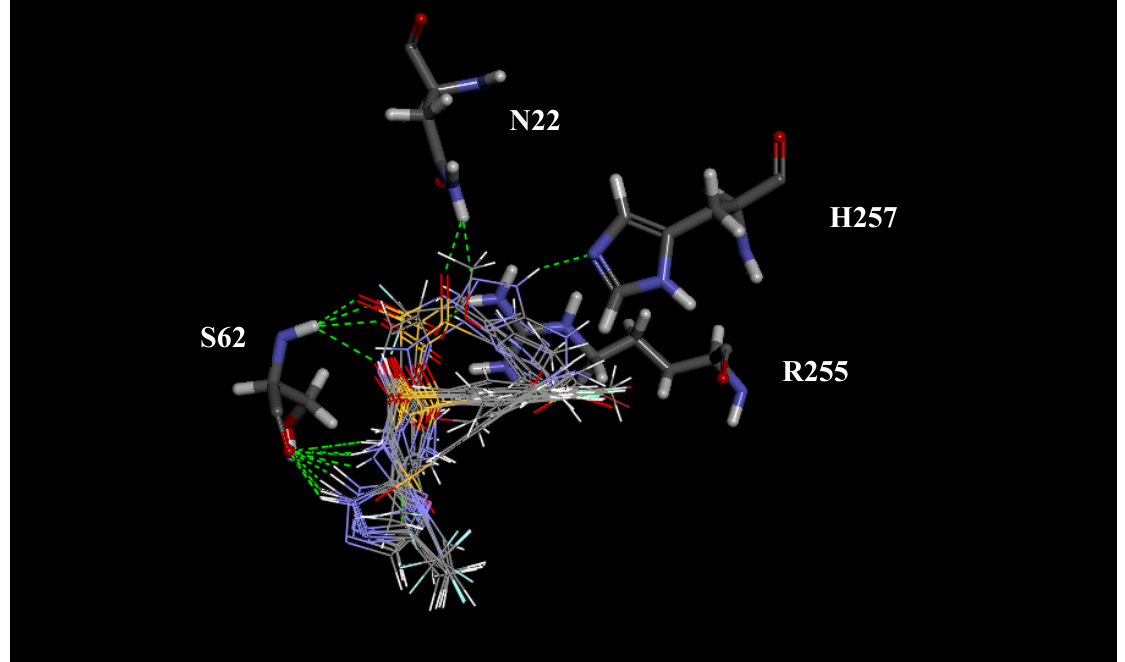
Figure 2. Intermolecular hydrogen bonds between P. falciparum DHPS and the synthesized ligands, sulfadoxine, sulfadiazine, and